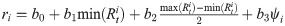
Source-sink population predictors.(A) Linear regression of state population size versus simulated trough infections, both on a log10 scale. Trough infections are those shown in Fig 4E. (B) Residuals from the regression of population size versus trough infections were used as the dependent variable in the multiple regression model, where the predictors were: the state’s seasonal minimum reproductive ratio, the immigration rate, and the seasonal amplitude of the reproductive ratio, measured as half the peak–trough difference in the reproductive ratio. Plot shows on the y-axis, the residuals, r
i, from panel A, along with the prediction of the residuals based on the multiple regression ri=b0+b1min(Rti)+b2max(Rti)−min(Rti)2+b3ψi, where Rti is the reproductive ratio, ψ
i is the immigration rate, and i indicates the state. Taken together, panels A and B demonstrate that the predictors of a source versus sink are: the population size, the minimum reproductive ratio, the amplitude of the reproductive ratio, and the immigration rate. (C) Map of the seasonal minimum reproductive ratio showing geographic clustering. (D) The residuals, r
i, versus the seasonal amplitude of the reproductive ratio (i.e., the transmission amplitude), point size and color indicate the immigration rate, ψ
i. (E) The residuals, r
i, versus the seasonal minimum reproductive ratio, point size and color indicate the immigration rate, ψ
i. The data used to make this figure can be found in S3 Data, S4 Data, S5 Data, S6 Data, S7 Data, and S8 Data.